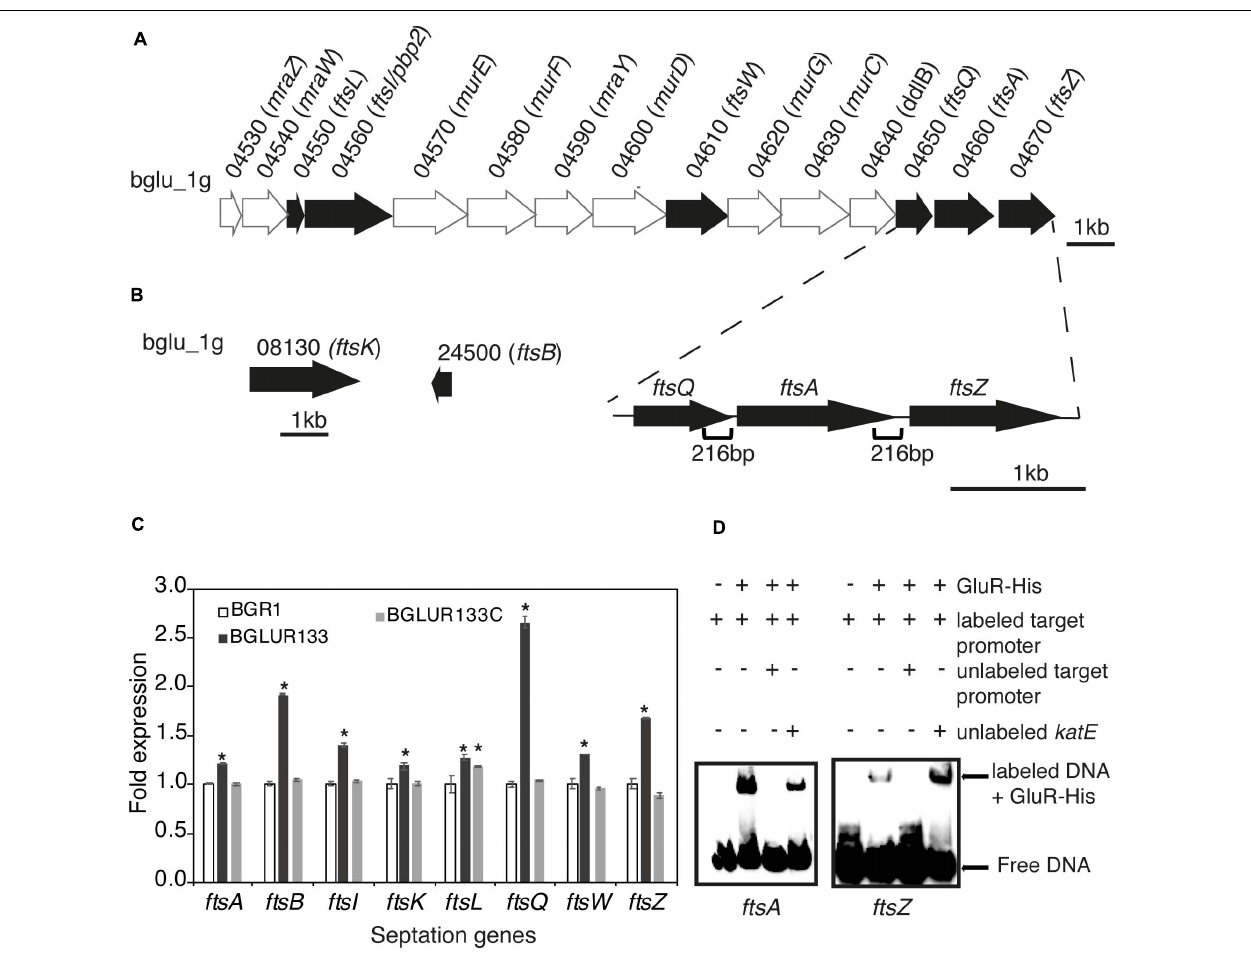
FIGURE 4 | GluR represses cell division and septation genes in Burkholderia glumae . (A) Genetic organization of the dcw cluster in BGR1. Dark arrows represent genes involved in septation during cell division, and light arrows are genes involved in cell-wall synthesis or with no known function. The section below the gene map indicates the positions and size of the respective putative promoters in this study. (B) Gene maps of additional cell-division genes outside the dcw cluster. (C) Expression levels of eight cell-division genes in the wild type (BGR1), gluR mutant, and complemented BGLUR133C strains compared by qRT-PCR. mRNA levels were normalized to 16S rRNA , and the fold expressions are relative to those of the wild type. Data are means ± standard error (SE) of triplicates; statistical analysis was performed by one-way ANOVA/Tukey’s correlation for multiple comparisons. * p < 0.05; [ F (48,71) = 1,536.273; p = 0.00]. (D) Electrophoresis mobility shift assay (EMSA) showed direct control of ftsA and ftsZ by GluR-His binding to the respective putative promoter regions; 0.75 µ M of GluR-His, 1 nM of labeled target DNA, 1 nM of unlabeled katE non-competitor DNA, and 20 nM of unlabeled target promoter DNA were used for EMSA. Full blot images with multiple contrasts are shown in Supplementary Figure 8